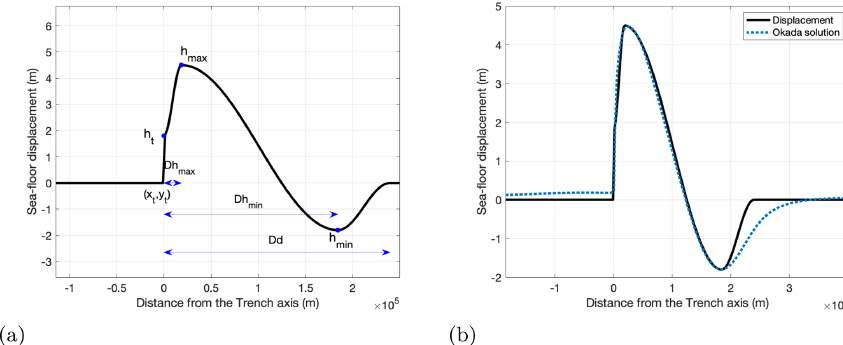
Figure 3. Geometry of the vertical seabed displacement (cross-section). (a) Example using Dh max / Dh min = 0 . 1, D d / Dh min = 1 . 3, h min /h max = 0 . 4, h max = 4 . 5m and h t /h max = 0 . 4. (b) Comparison to an Okada solution for slip occurring on a fault with geometry similar to the Cascadia subduction